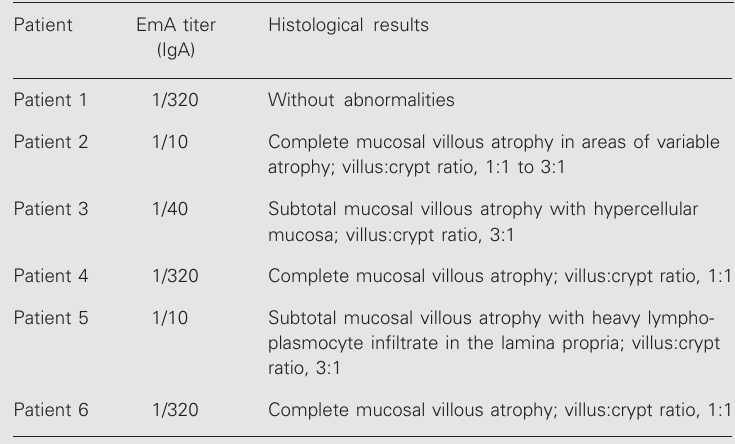
Table 3. Correlation between histological results and measurements of plasma antien- domysial antibody titer among group 1 patients. Patient EmA